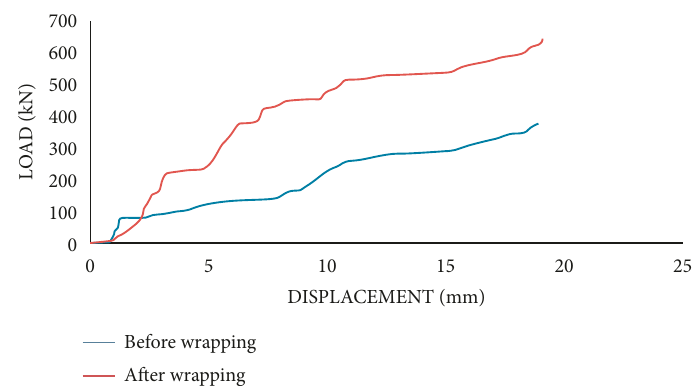
Figure 17: Load-deflection behavior of GG35 specimens before and after wrapping.